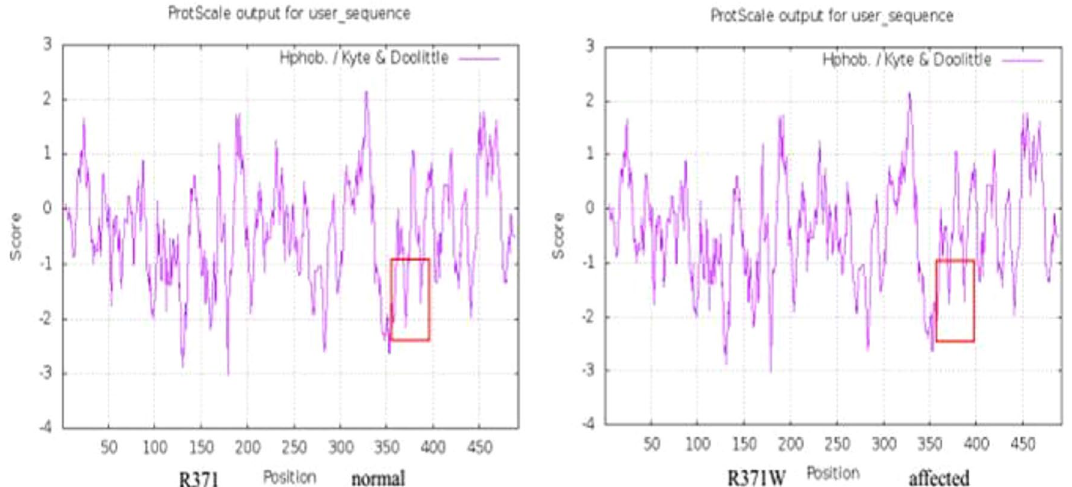
Figure 4. ProtScale analysis of the human protein with the equivalent mutation (R371W) confirming an increase in overall hydrophobicity.